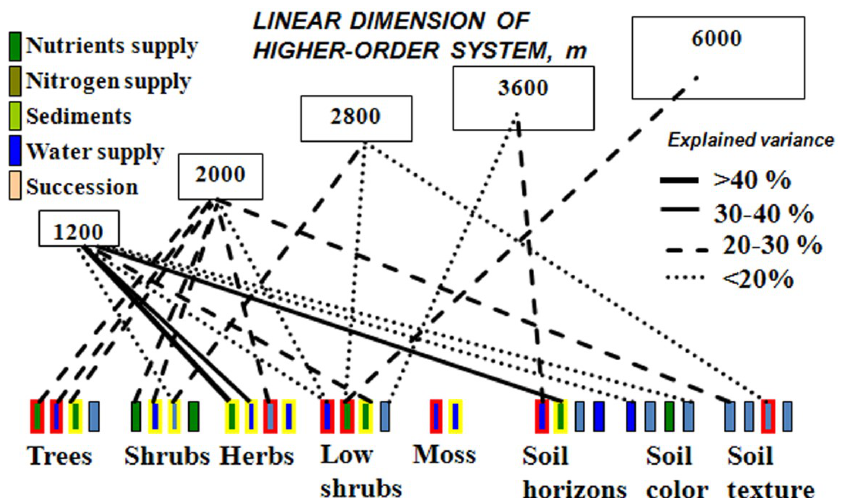
Figure 3: External effects of linkages between soil-vegetation properties D order geosystems relief. Percentage of variance explained by the Response regression surface equation (3). Red outline: internal non-spatial factors are stronger than external spatial ones. Yellow outline: external spatial factors are more